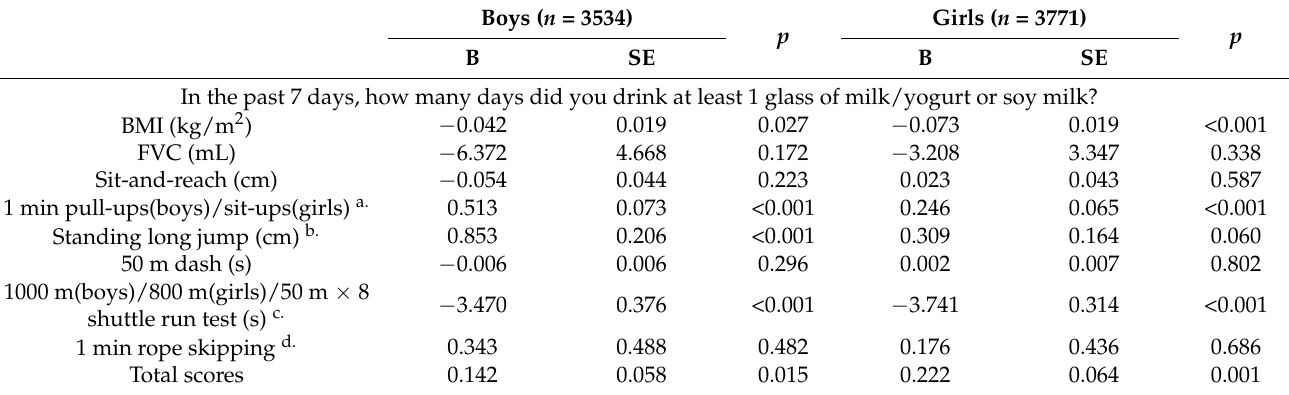
Table 5. Association between frequency of dairy product intake and physical fitness in children and